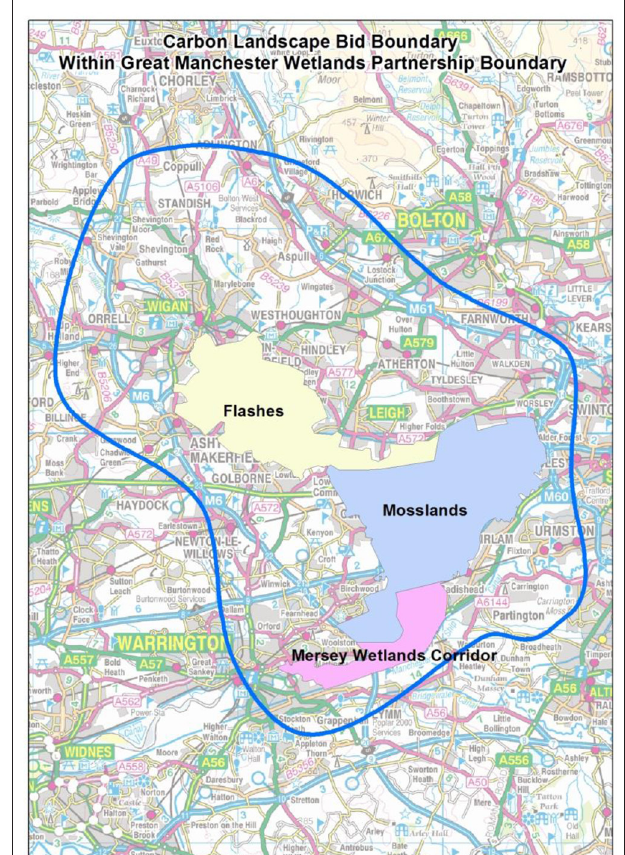
FIGURE 2 | Carbon Landscape and Greater Manchester Wetlands boundaries. Source: carbon landscape project. Blue line indicates the GMWP geography. The Carbon Landscape area is shown in cream, pink and blue, showing the Flashes, Mosses and Wetlands sub-areas. These sub-areas are based on landscape character assessments. Source: Great Manchester Wetlands